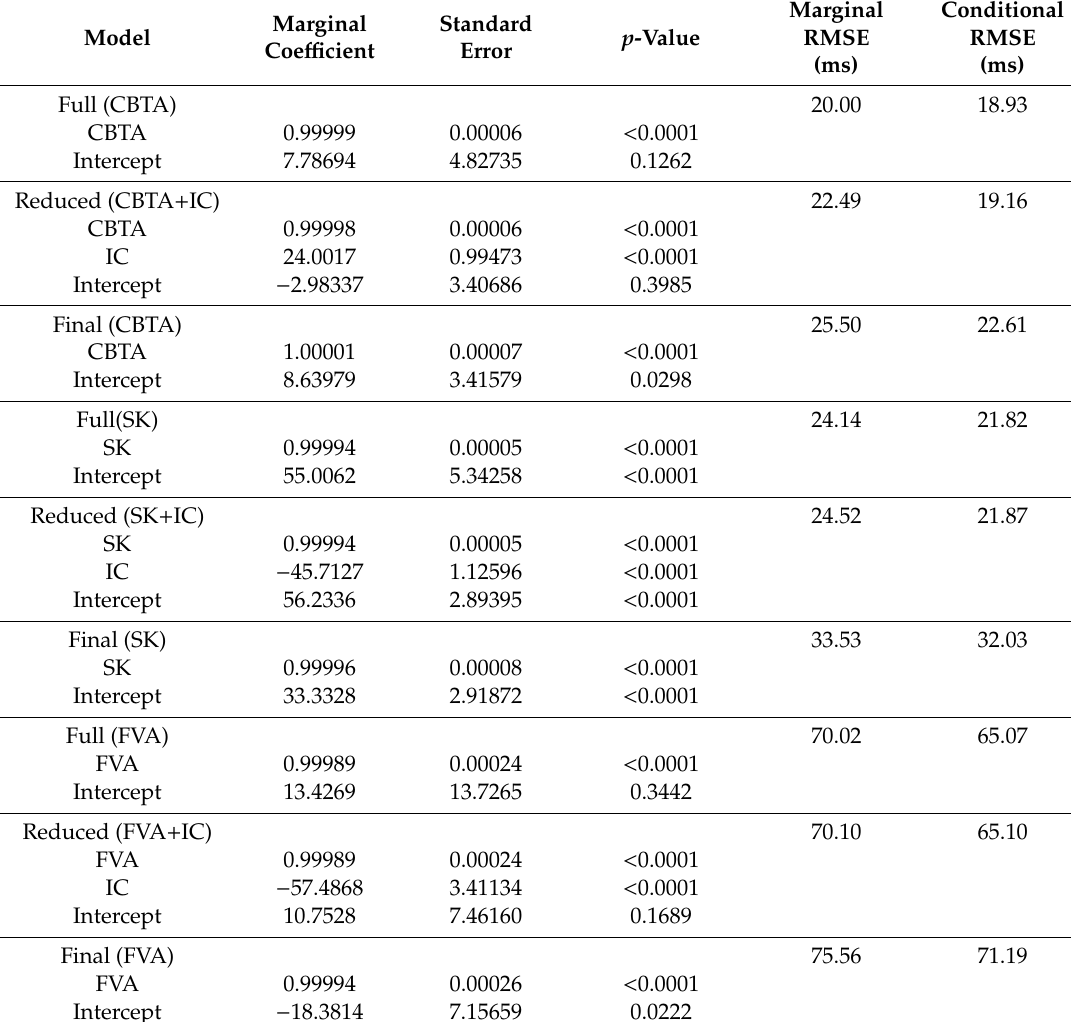
Table 4. Model development